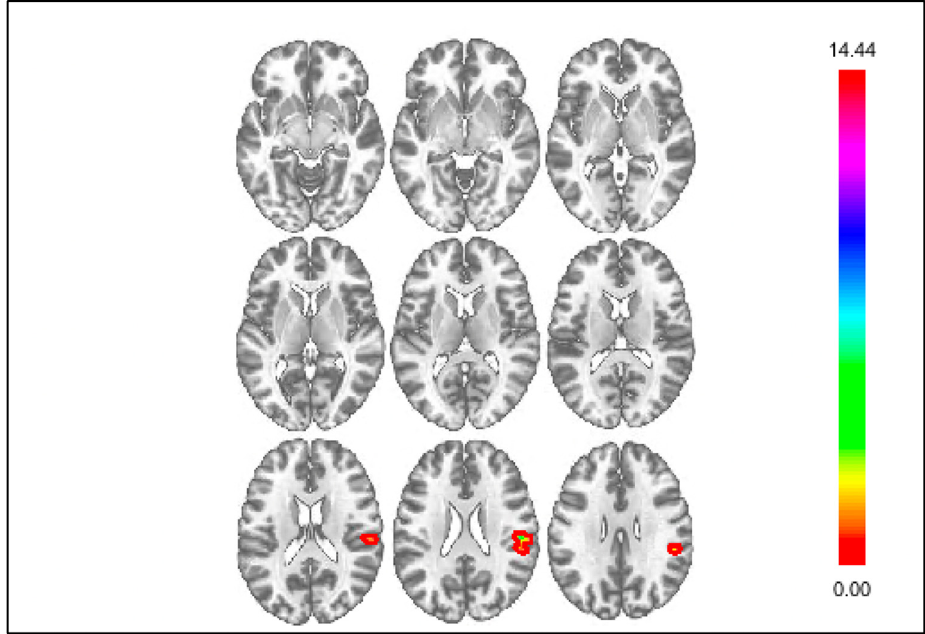
Figure 4. Whole brain results showing significant clusters for connectivity with the DS seed for positive outcomes, gain > control.